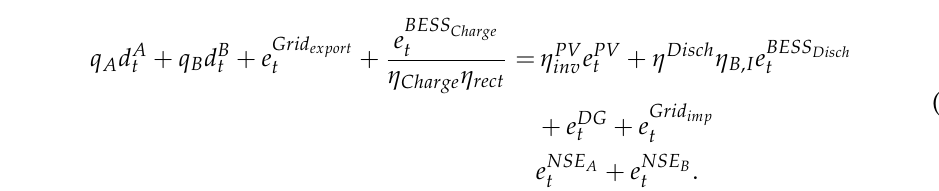
Figure 5. Total welfare in a UC objective function without predetermined C NSE > 0 ( right predefined C A , C B NSE t NSE t